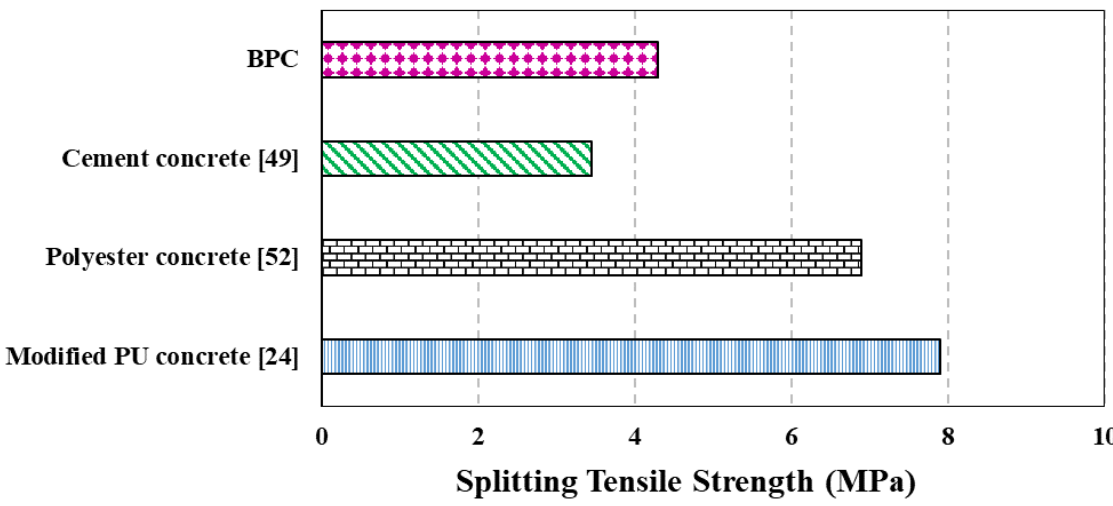
Figure 7. BPC splitting tensile strength comparison with literature.